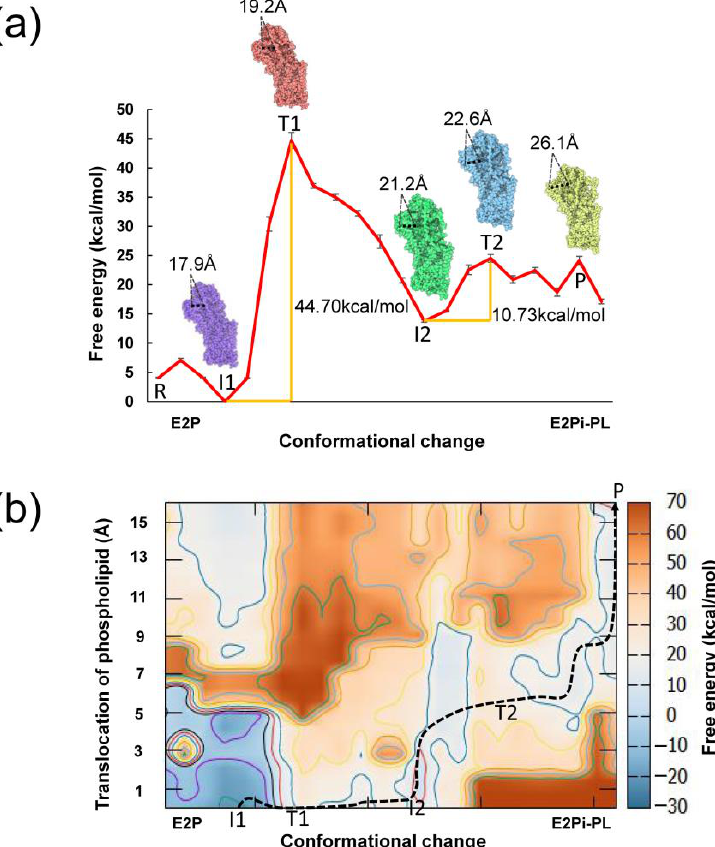
Figure 2. ( a ) The CG free energy profile for the conversion between the E2P and E2PPi-PL states. The representative configurations during the conformational changes were named the reagent state (R), the intermediate structure 1 (I1), the transition structure 1 (T1), the intermediate structure 2 (I2), the transition structure 2 (T2) and the product E2Pi-PL state (P). The energy barriers are shown in orange. The Cα–Cα distances between I121 (TM2) and W376 (TM4) were used to distinguish between the representative conformations (R, I1, T1, I2, T2, P). The distances between atom CA of residue I121 (TM2) and W376 (TM4) for I1, T1, I2, T2 and product structures are shown in the picture, with the value of 17.9 Å , 19.2 Å , 21.2 Å , 22.6 Å and 26.1 Å , respectively (measured with the all-atom structures). This means that the phospholipid transport channel between TM2 and TM4 gradually opens from E2P to the E2Pi-PL state. The free energies were calibrated with the free energy of structure I1. ( b ) Coupled free energy map of the conformational change in P4-ATPase and phospholipid transport. One possible least-energy pathway is indicated by a black dashed line. The barrier along the route is 46.49 kcal/mol.